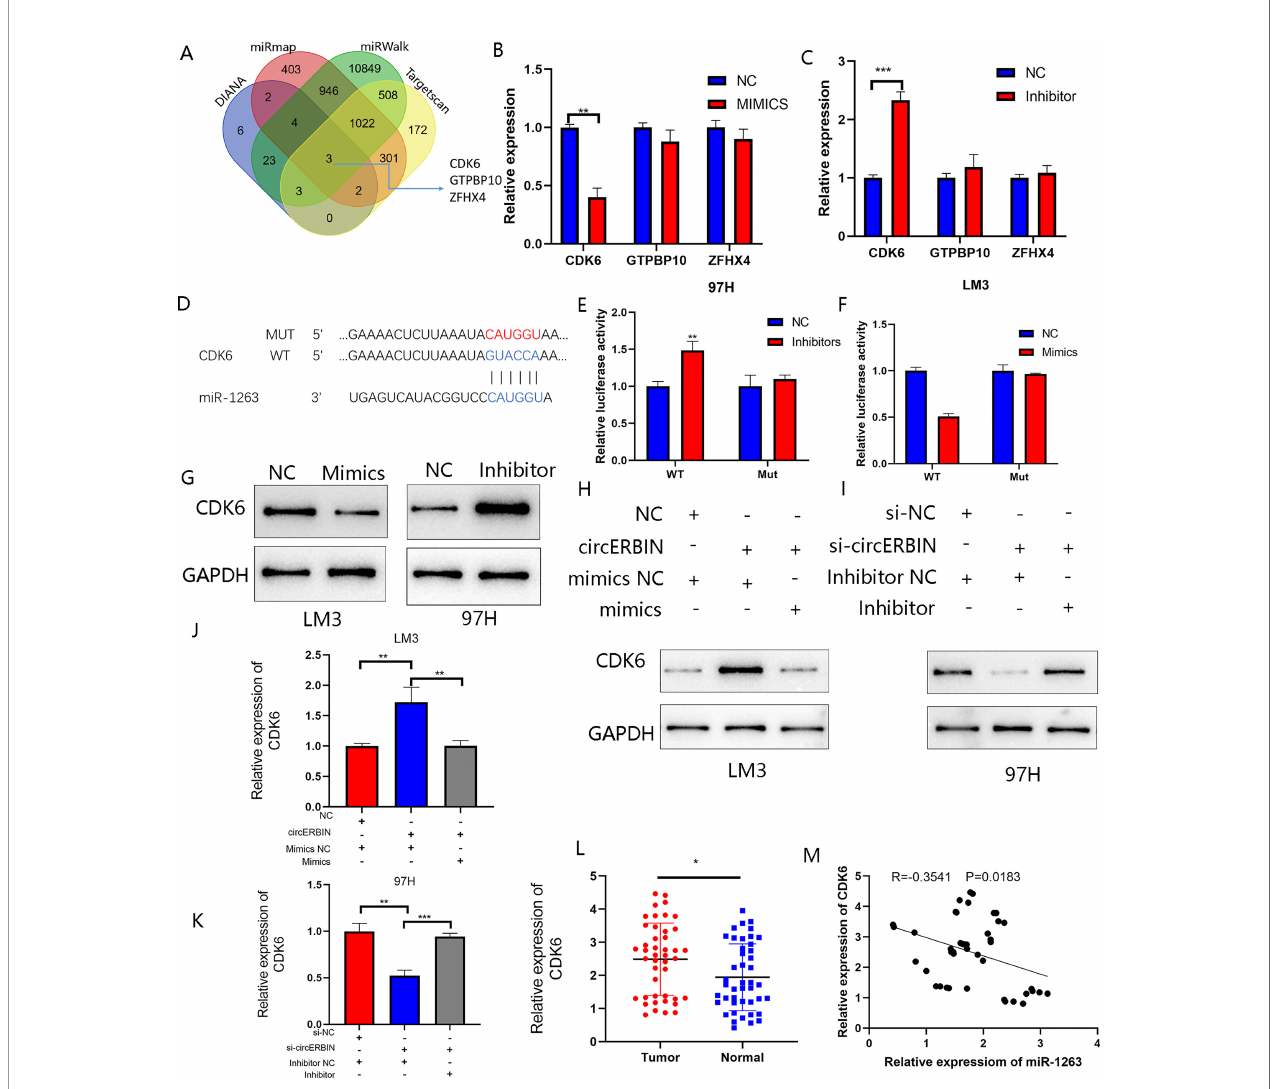
FIGURE 6 | CDK6 is a direct target of miR-1263. (A) Schematic illustration exhibiting overlapping of the target mRNAs of miR-1263 predicted by the DIANA, miRmap, miRwalk, and Targetscan databases. (B, C) Expression of predicted target genes in LM3 and97H cells transfected with miR-1263 mimics, an inhibitor, and corresponding NC. (D) Schematic illustration of the WT and MUT CDK6 sequences at the miR-1263 binding site. (E, F) The effects of miR-1263 mimics and inhibitor on the luciferase activities of the WT and MUT CDK6 mRNA 3 ’ -untranslated regions as detected by qRT-PCR. (G) The effects of miR-1263 on the protein expression of TDO2 were detected by western blot analysis. (H, I) Western blotting showing CDK6 protein expression in transfected 97H and LM3 cells. (J, K) QRT-PCR showing CDK6 mRNA expression in transfected 97H and LM3 cells. (L) Relative CDK6 expression in 44 pairs of fresh frozen HCC tissues and matched normal liver tissues. (M) An obvious negative correlation between the levels of miR-1263 and CDK6 in 44 pairs of fresh frozen HCC tissues and matched normal liver tissues as determined by Pearson correlation analysis. (* p < 0.05, ** p < 0.01, *** p <